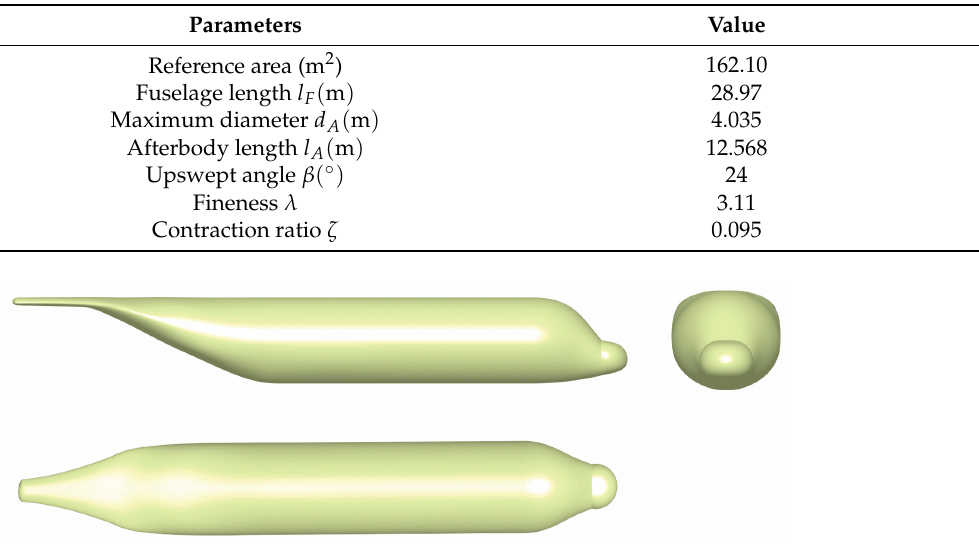
Figure 3. Three views of the